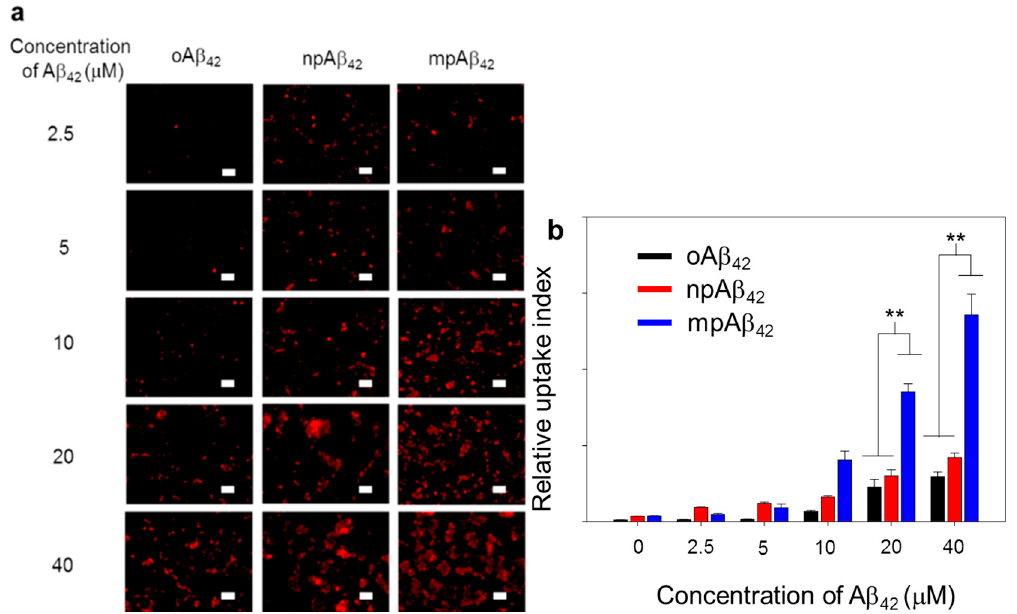
Figure 7. Phagocytic action of BV-2 cells. ( a ) Laser scanning confocal microscope (LSCM) images of BV-2 cells after co-incubation with oA β 42 , npA β 42 , and mpA β 42 , respectively ( n = 8). A β 42 in different forms was IHC stained using 6E10 as the primary antibody ( λ ex = 565 nm, λ em = 680–730 nm). Scale bar: 50 μ m. ( b ) Relative uptake index of A β 42 by BV-2 cells. One-way ANOVA was used to examine the mean differences between the end points of the data groups. ** P < 0.01. Error bars represent mean ± s.d. ( n = 8).